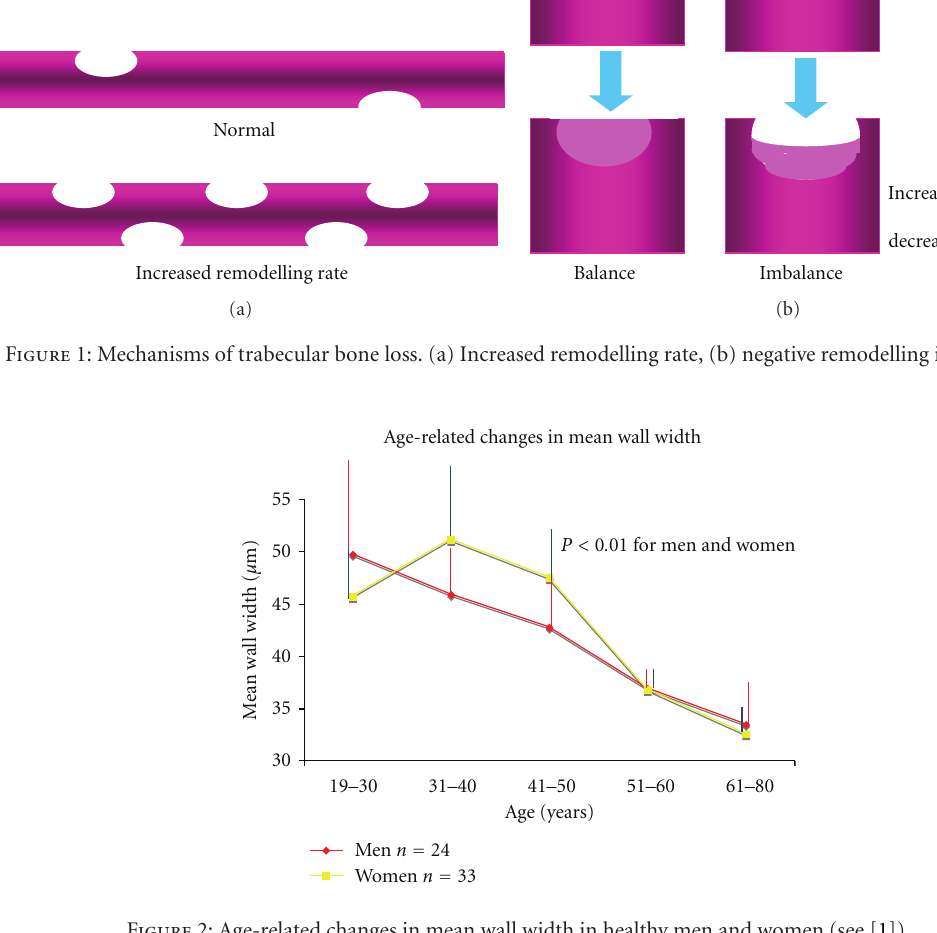
Figure 2: Age-related changes in mean wall width in healthy men and women (see